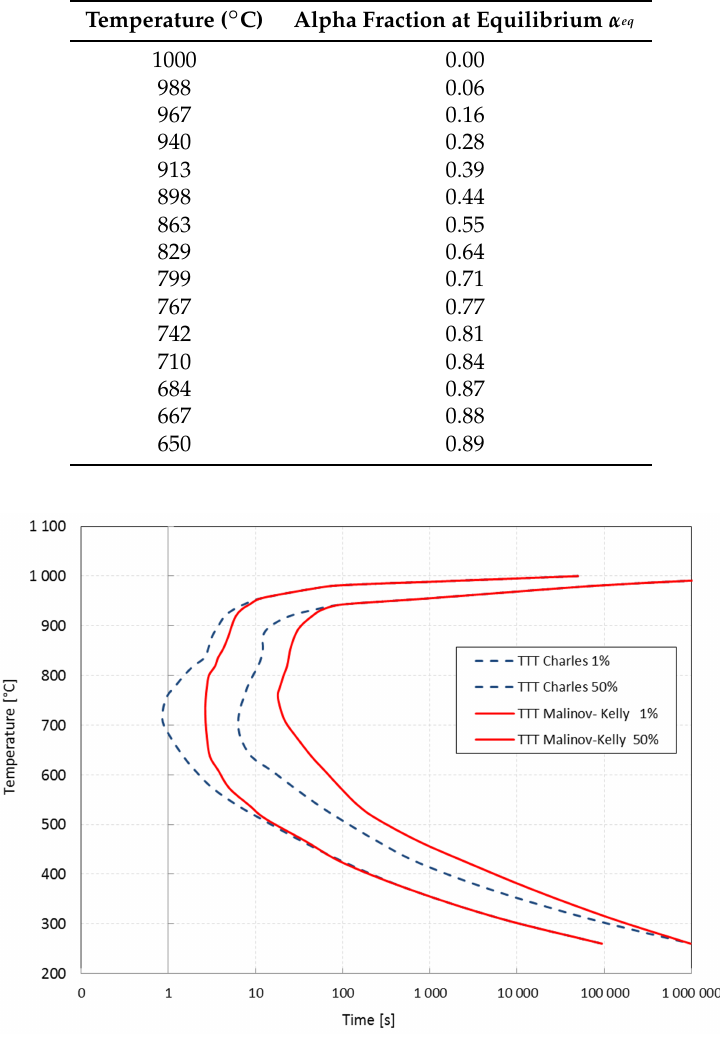
Figure 5. TTT-diagrams for Ti6Al4V: proposed from Charles et al. in [10] (dashed line) and a mix of Figure 5: TTT-diagrams for Ti6Al4V: proposed from Charles et al. in [7] (dashed line) and a mix Malinov’s [26,27] and Kelly’s [9] data (continuous of Malinov(cid:146)s [24],[25] and Kelly(cid:146)s [6] data (continuous line)